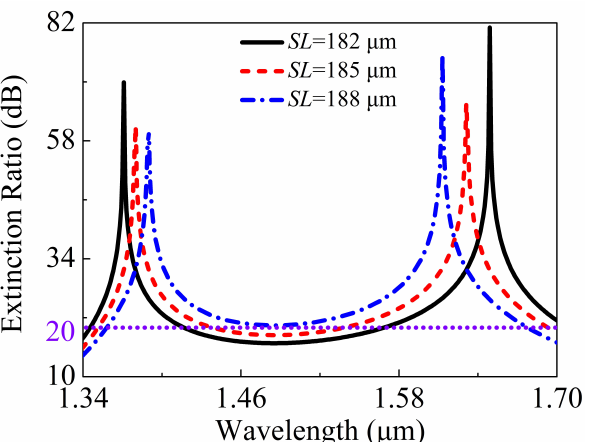
Figure 12. The ERs in the core A of the proposed V-DC-PCF PBS as functions of the wavelength for different SL . Table 3. Comparisons between the proposed V-DC-PCF PBS and reported surface plasmon resonance (SPR)-based DC-PCF PBS.